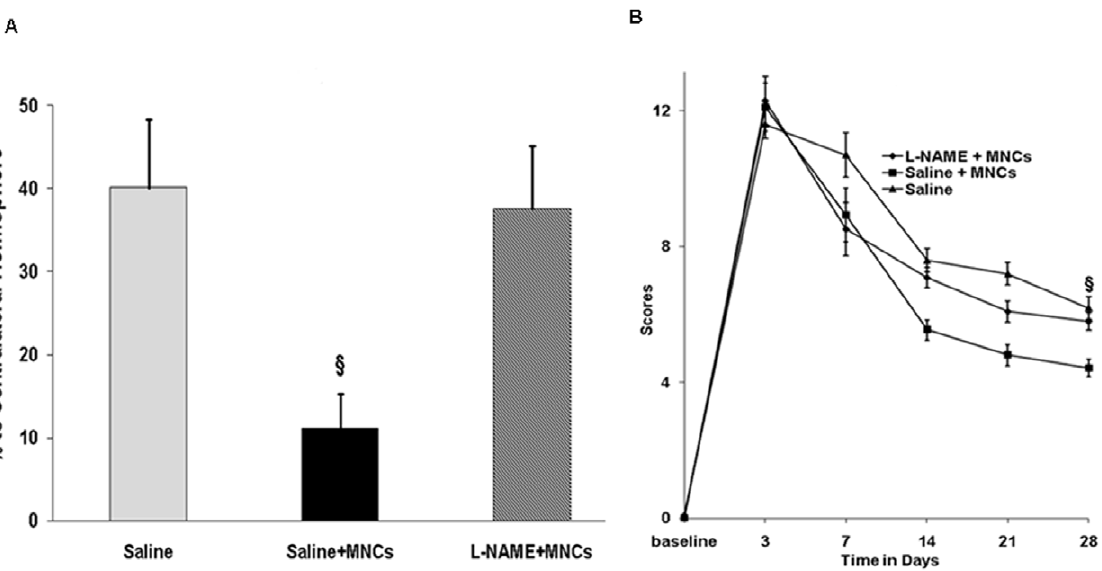
Figure 6. L-NAME inhibits the beneficial effect of MNCs. (A) Chronic infarct cavity at 28 days after stroke in animals treated with saline or MNCs. Animals at 24 hrs after stroke received saline followed by IV MNCs (10 million cells), or L-NAME followed by IV MNCs (10 million cells), or saline only. Lesion size was reduced by MNCs at 28 days after stroke. However, pre-treatment with L-NAME before MNC infusion abolished this reduction in lesion size ( 1 p , 0.05 compared with saline). The lesion size was calculated as a percent of the contralateral cortex N=8 per group. (B) Neurological deficits serially evaluated after stroke in animals treated with saline IP followed by IV infusion of MNCs or L-NAME IP followed by IV infusion of MNCs. At 28 days, animals treated with saline followed by MNCs showed a significant reduction in deficits compared with animals treated with L- NAME + MNCs or compared with animals treated with saline only ( 1 p , 0.05). The x-axis represents the time in days after stroke. Baseline refers to the time point before stroke. N=8 per